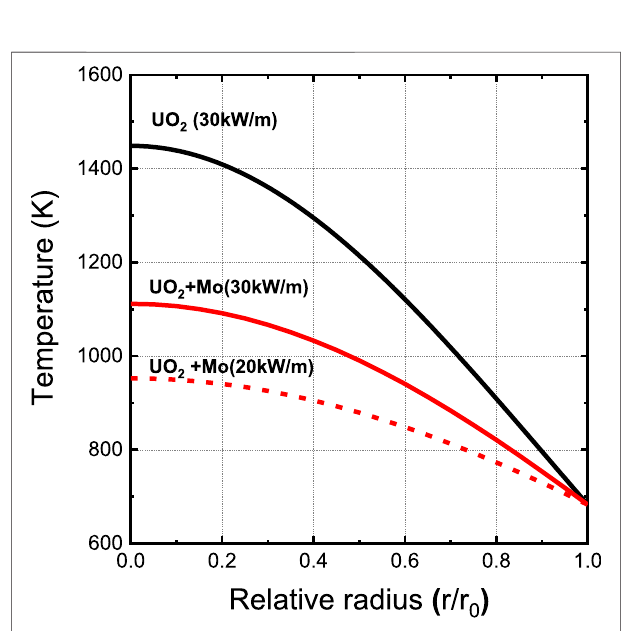
FIGURE 7 | Comparison of radial temperature pro fi le between UO 2 and UO 2 – Mo